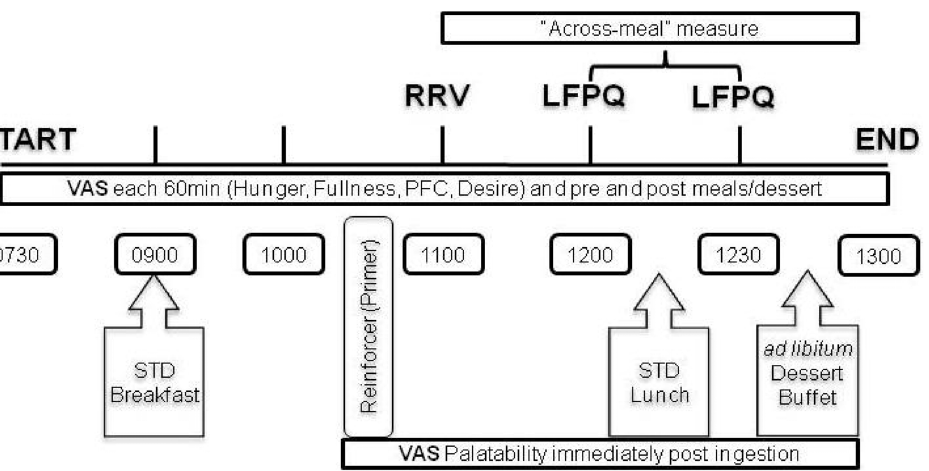
Figure 1. Protocol for the two testing sessions. Note that in order to perform the 24 hour fast under the FASTED condition, subjects did not eat a standardized breakfast; the fasting period was slightly less than 24 hours due to the standardized consumption (100 kcal: 50 kcal snack and 50 kcal fruit) of the primers used in the RRV task.